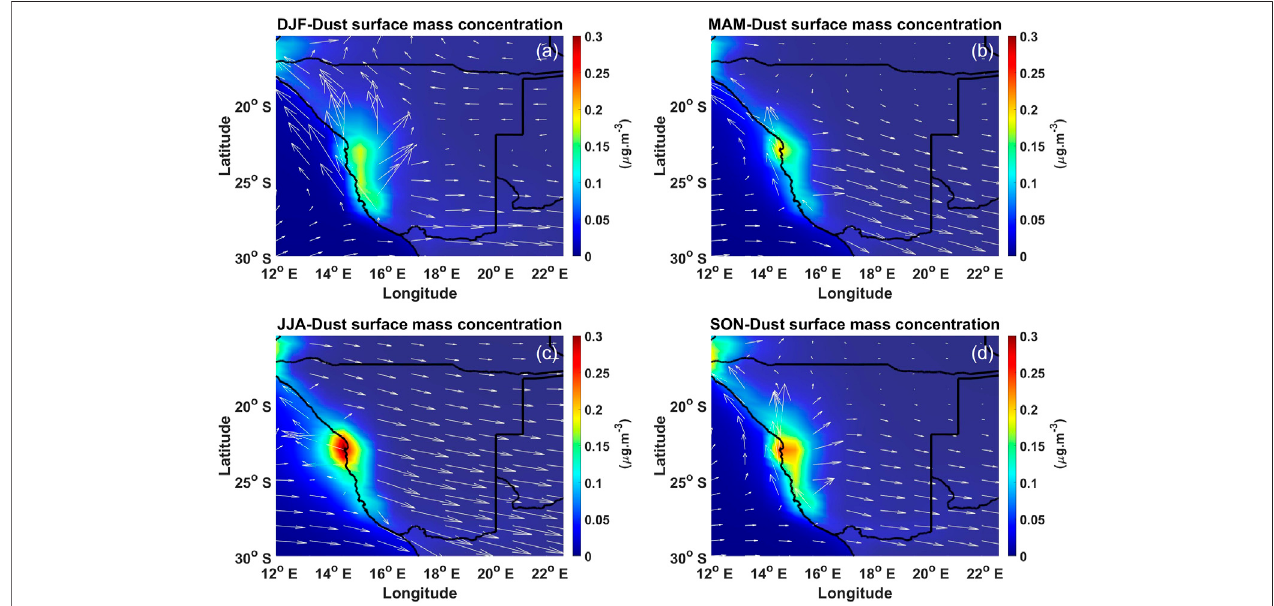
FIGURE 2 | Seasonal averaged dust surface mass concentration overlay with wind vectors for the period 1998 – 2020 in (A) DJF, (B) MAM, (C) JJA and (D) SON, obtained from MERRA-2.